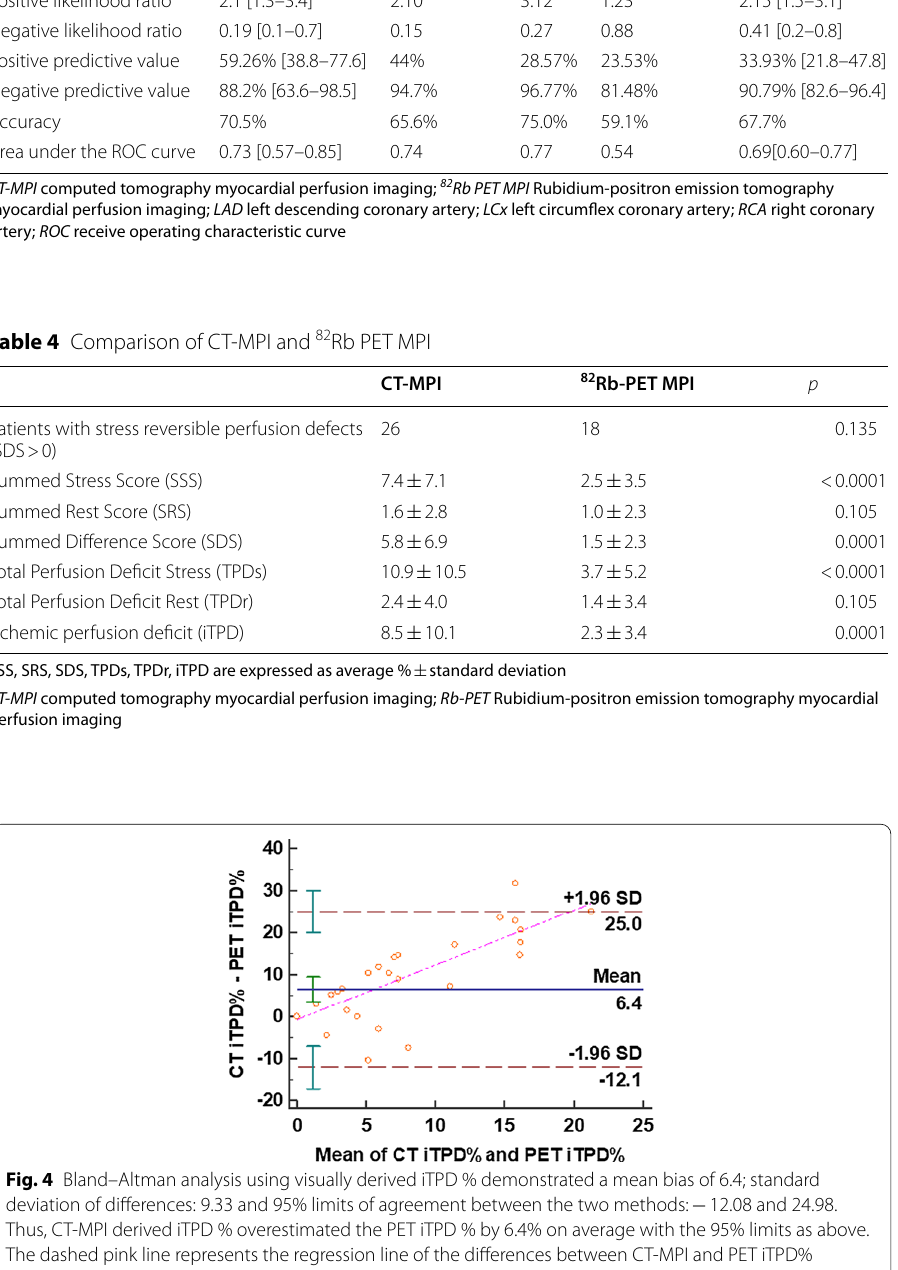
12.08 and 24.98. −